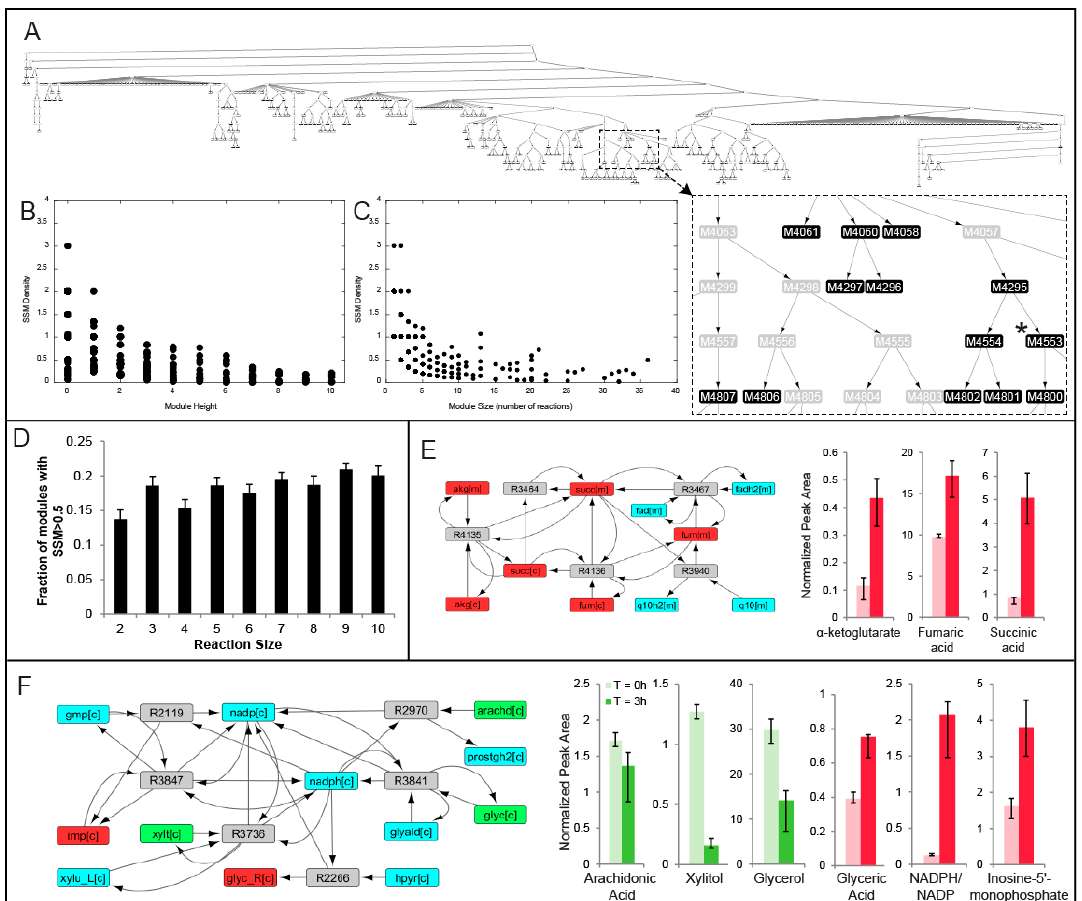
Figure 3. ( A ) MMA partition for Liver 1 where each node represents a module of reactions and the darker shaded nodes denote a higher statistically significant metabolite (SSM) density. For each module in Liver 1 with at least one significant metabolite, the SSM density is plotted against ( B ) hierarchical modular height and ( C ) module reaction size; ( D ) the fraction of modules with an SSM density greater than 0.5 is plotted against module reaction size. The modular compositions as well as the significantly elevated/depleted metabolites within the modules are both shown for an intuitive module that could have been predicted using PEA ( E ) and one where PEA would not have been effective at capturing the NADPH-mediated interaction ( F ). These modules were both derived from the partition of Recon 2.1 based on the metabolomics data collected from Liver 1. Red, green and blue nodes represent accumulating, depleting and non-significant/non-measured metabolites respectively.